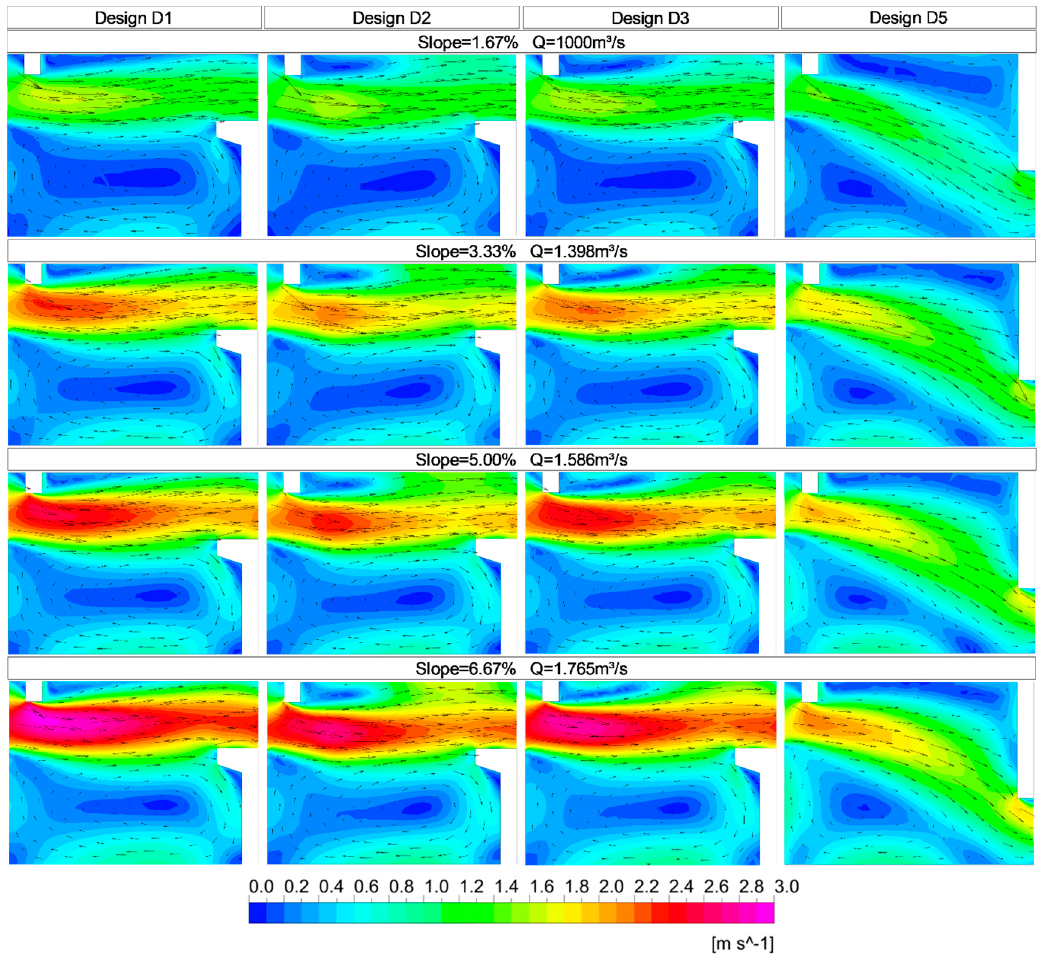
Figure 8. Velocities (V) in planes parallel to the bottom with a distance of z/h = 0.4, for the four slopes tested and for four designs: reference (D1), with a cylinder of h = 0.4 m (D2), with a cylinder of h = 0.2 m (D3) and with slots positioned on alternate sides (D5).